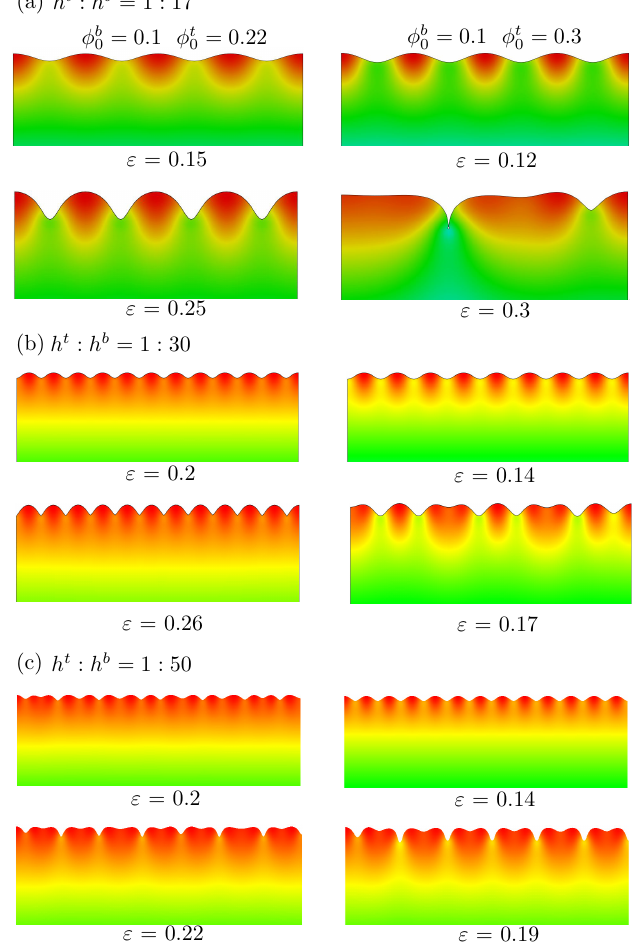
Figure 3. Surface morphologies of bilayer hydrogels under different levels of compressive strain marked below each figure for different thickness ratios of upper and lower layers: ( a ) h t / h b = 1/17; ( b ) h t / h b = 1/30; ( c ) h t / h b = 1/50. The initial volume fraction of polymer chain in the lower layer was = 0.1. Two initial volume fractions of polymer chain in the upper layer were considered: φ b φ b 0 = 0.3, shown in the left and right columns, and φ b 0